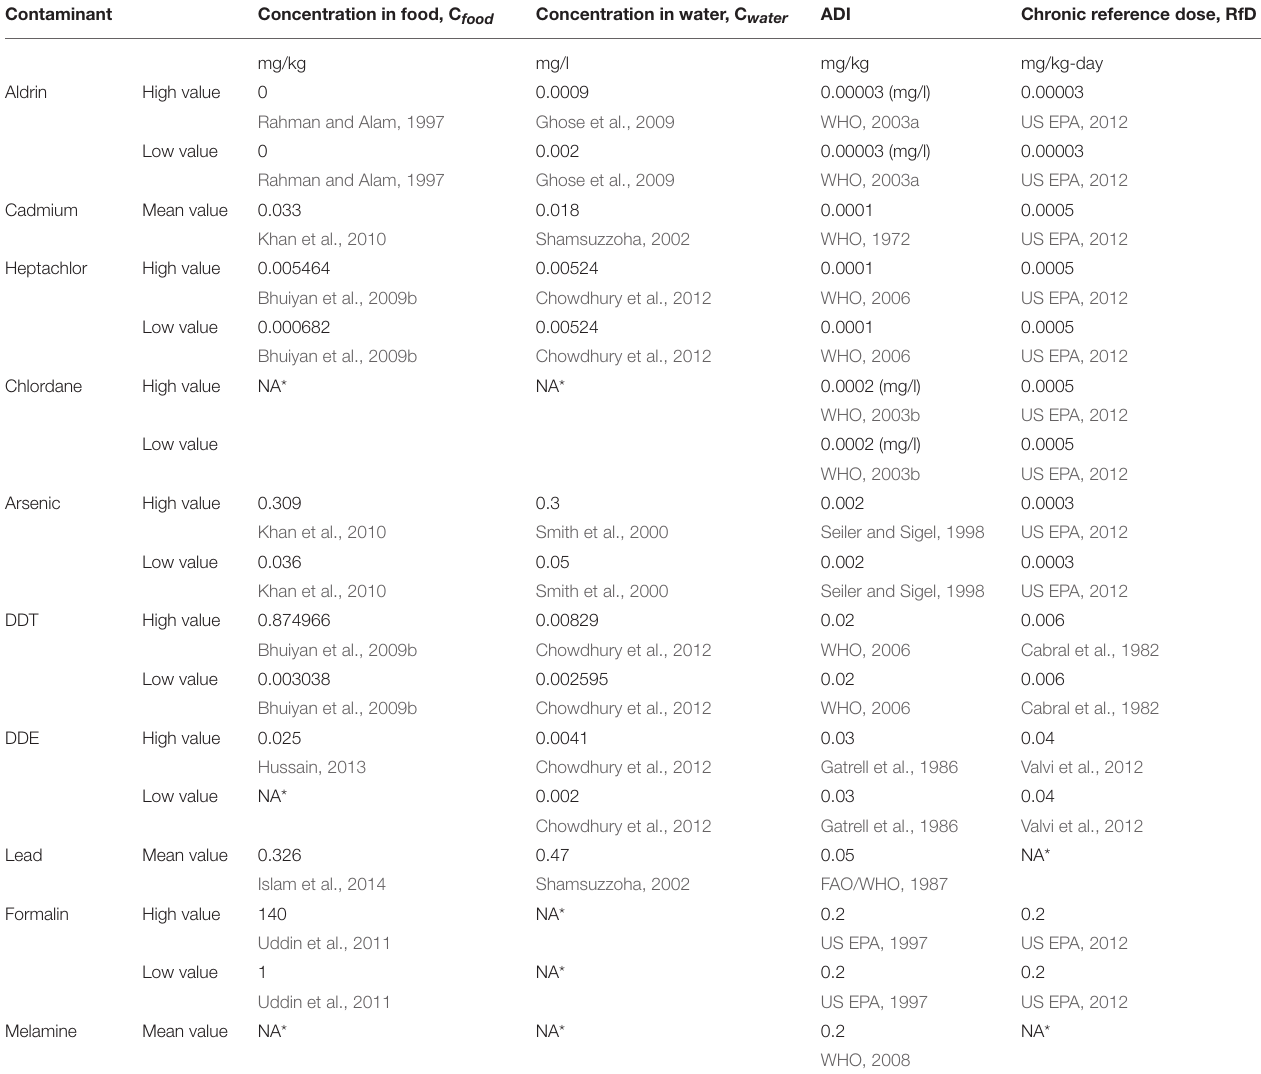
TABLE 4 | Toxicity continuum ranked from the most harmful to the least harmful contaminants based on their respective allowable/total daily intake (ADI/TDI) values.